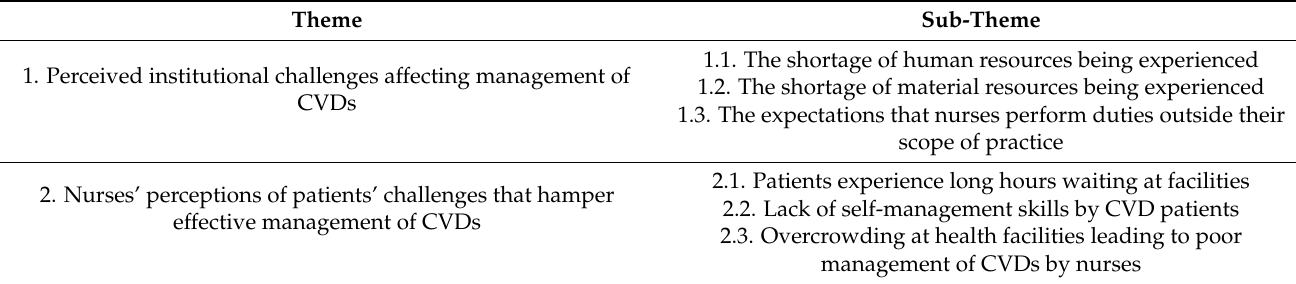
Table 1. Themes and sub-themes of nurses’ experiences during the management of cardiovascular diseases